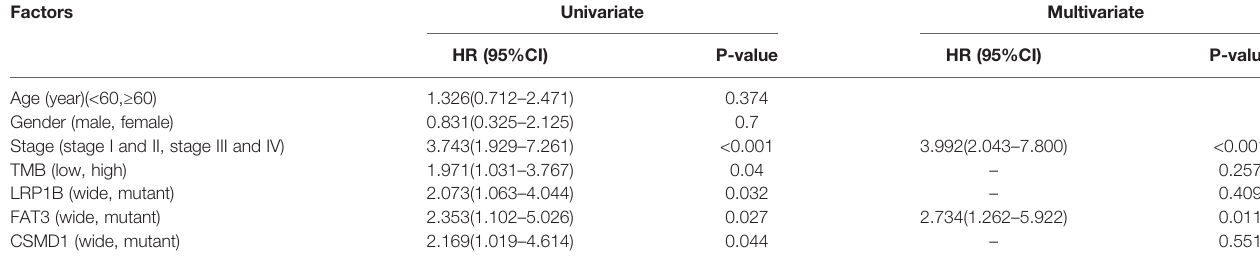
TABLE 1 | Univariate and multivariate Cox analysis of esophageal cancer patients by the IBM SPSS Statistics (version 20). Factors